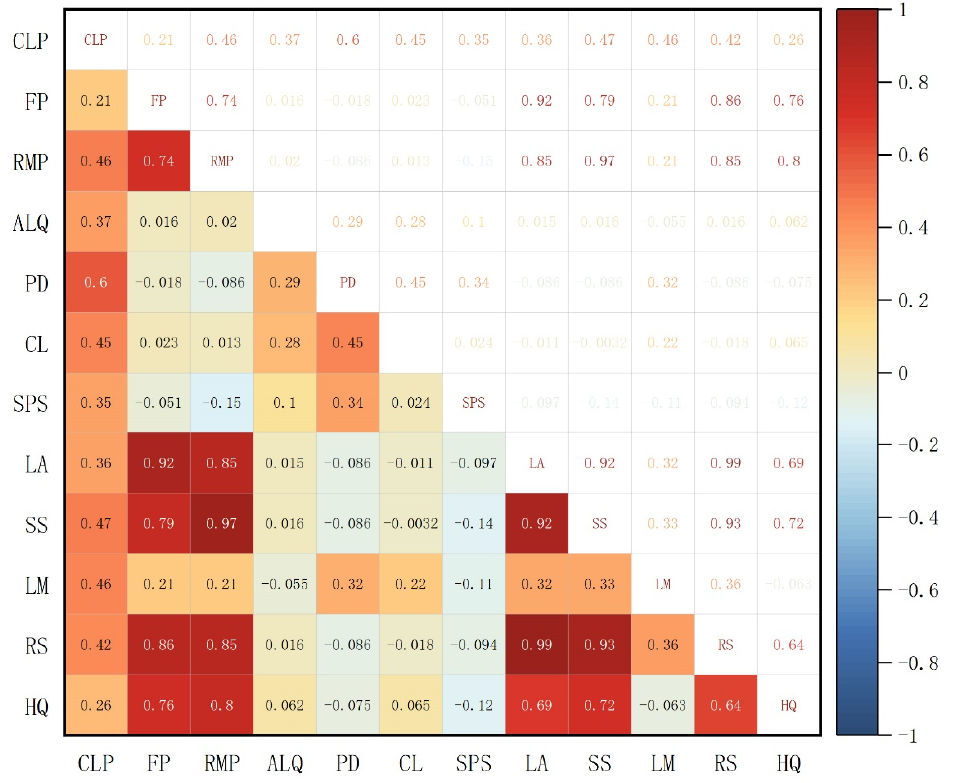
Figure 5. Spearman correlation analysis of subfunctions of PLE.